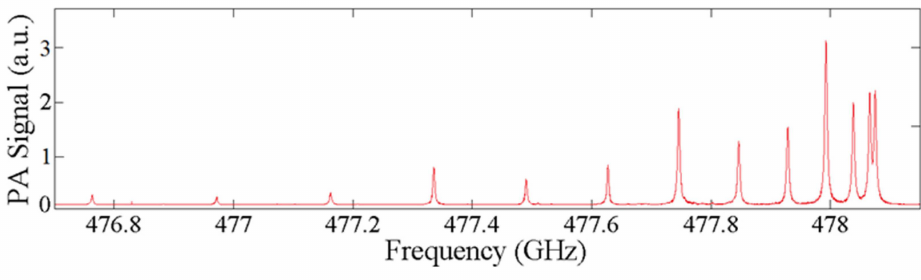
Figure 7. Methyl cyanide spectra data collected, using an improved 7 ˆ 2 ˆ 0.01 mm 3 cantilever sensor design, at 15